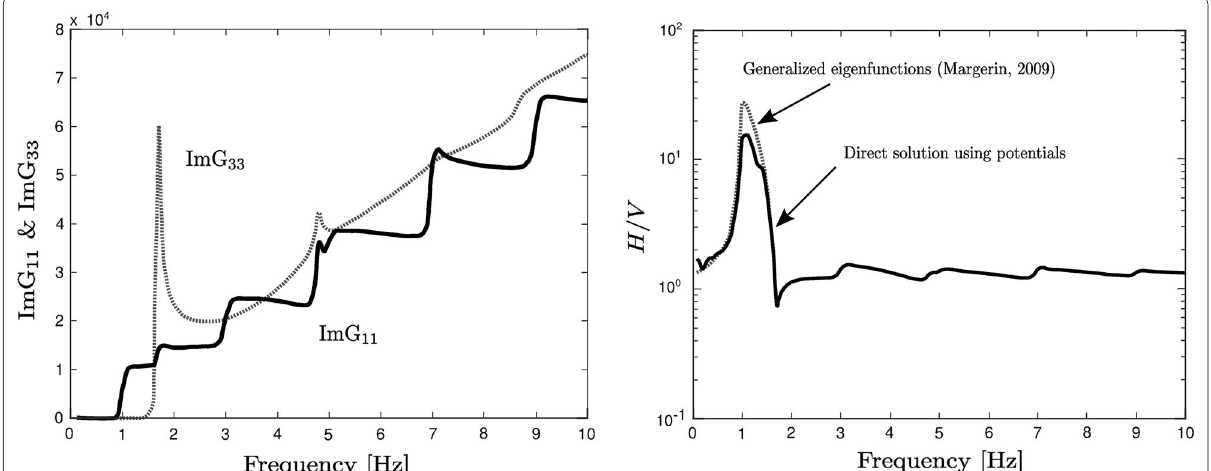
Fig. 2 ( Left ) Imaginary part of Green’s functions G 11 and G 33 for a layer over a half‑space. Black line corresponds to the horizontal response while dot- ted line represents the vertical one. ( Right ) H / V computed with Eq. 9. Dotted line was computed with Margerin’s (2009) method